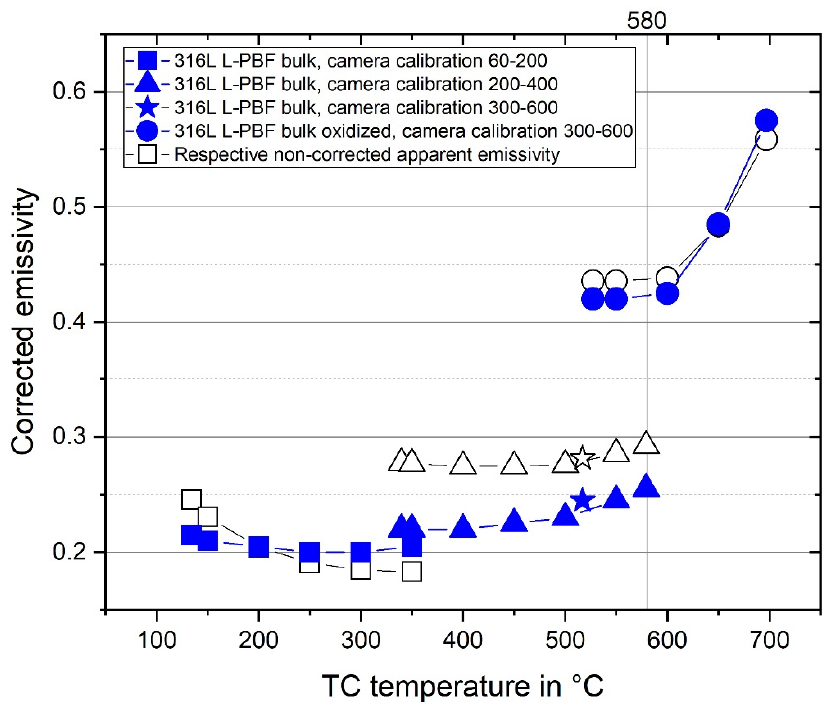
Figure 13. Comparison of corrected (blue symbols) and non-corrected apparent (black hollow symbols) emissivity values of 316L L-PBF bulk surface over measured TC temperatures .